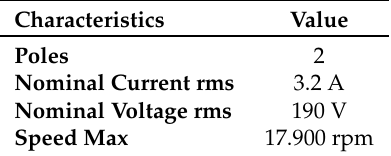
Table 2. Induction machine